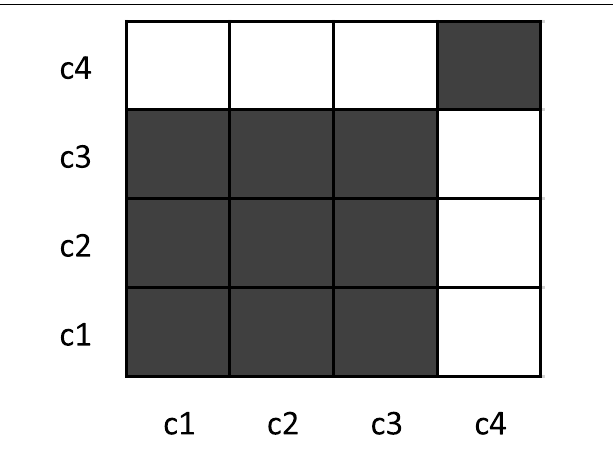
FIGURE 2 | Example recurrence plot for toy data. The dark squares in the plot indicate recurrence (identical/similar coordinates), while the white points indicate the absence of recurrence. Note that the recurrence plot (RP) is, by convention, rotated by 90 ◦ compared to the conventional display of a matrix, so that time runs from the lower-left to the upper-right of the plot. Recurrence measures for this plot are: %REC = 62.5%; %LAM = 90%; meanV = 3; maxV = 3. See text for how these values are